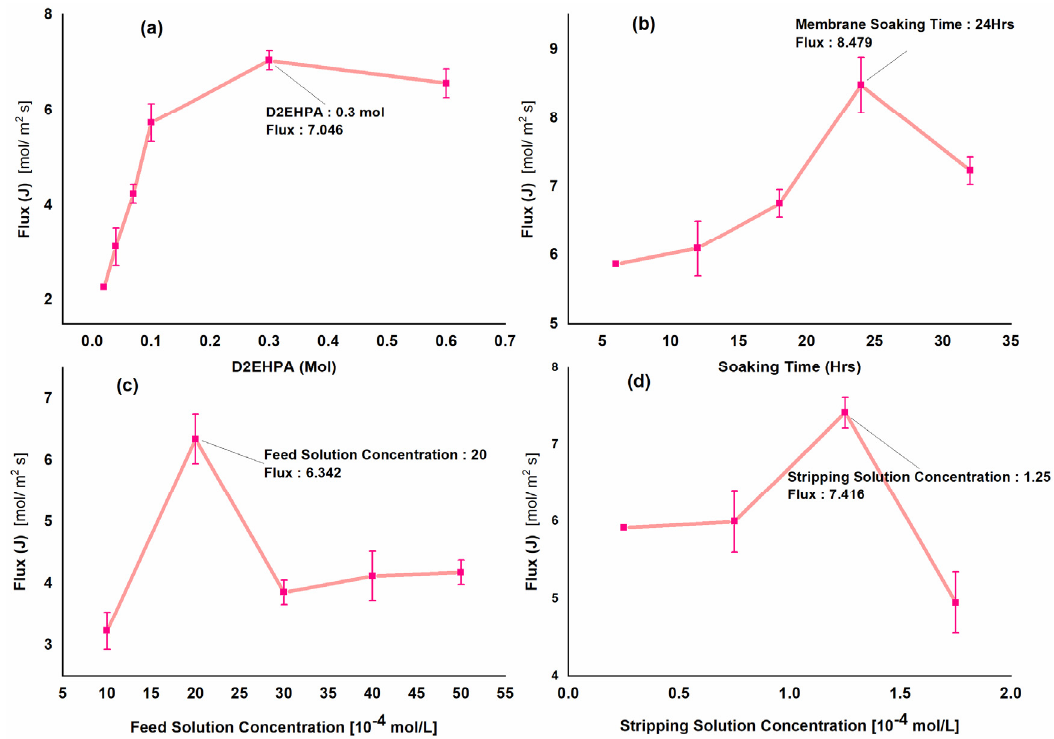
Figure 8. Flux at various concentrations of D2EHPA ( a ), membrane soaking time ( b ), initial con- centration of feed phase ( c ), and initial concentration of strip phase ( d ) for Cr (III) extraction.